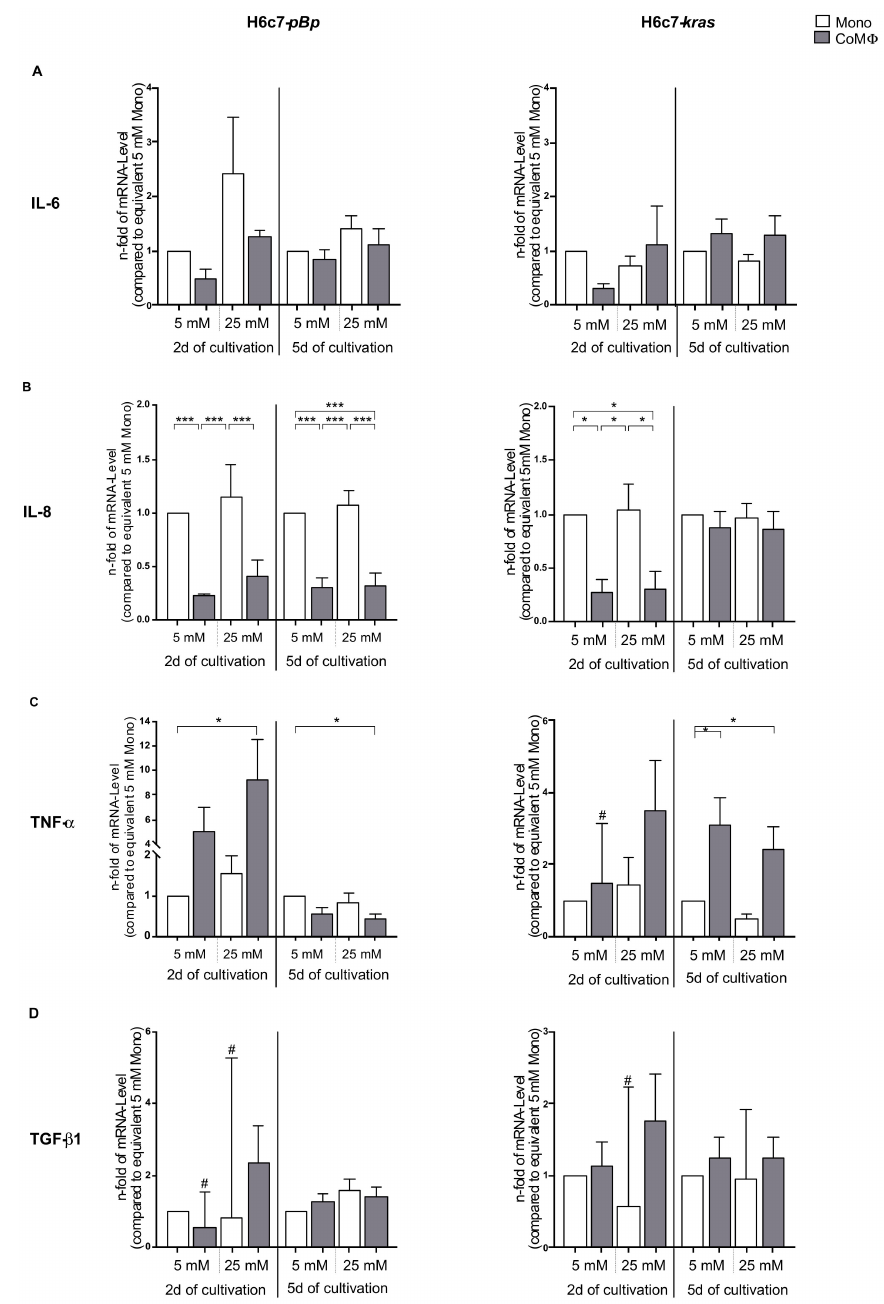
Figure 1. The presence of macrophages and hyperglycemia impacts mRNA levels of EMT and CSC inducers in PDEC. H6c7- pBp or H6c7- kras cells were cultivated in mono- or coculture with M1-polarized macrophages (M Φ ) under normo- or hyperglycemic conditions (5 or 25 mM of D -glucose) for 2 or 5 days. The epithelial cells were separated from direct coculture with macrophages via CD11b-MACS depletion of M1-M Φ or harvested from monoculture and used for qRT-PCR analysis. The relative mRNA levels of IL-6 ( A ), IL-8 ( B ), TNF- α ( C ) and TGF β -1 ( D ) for both cell lines are depicted. They are normalized to the housekeeping gene GAPDH and presented as n -fold expression compared with the monocultured 5 mM sample from the equivalent cultivation timespan. Normally distributed data are presented as mean and standard error of mean; not normally distributed data (indicated via #) are shown as median and interquartile range. * 0.05 > p > 0.0332; *** 0.002 > p > 0.0001; n = 4 for 2-day culture; n = 7 for 5-day